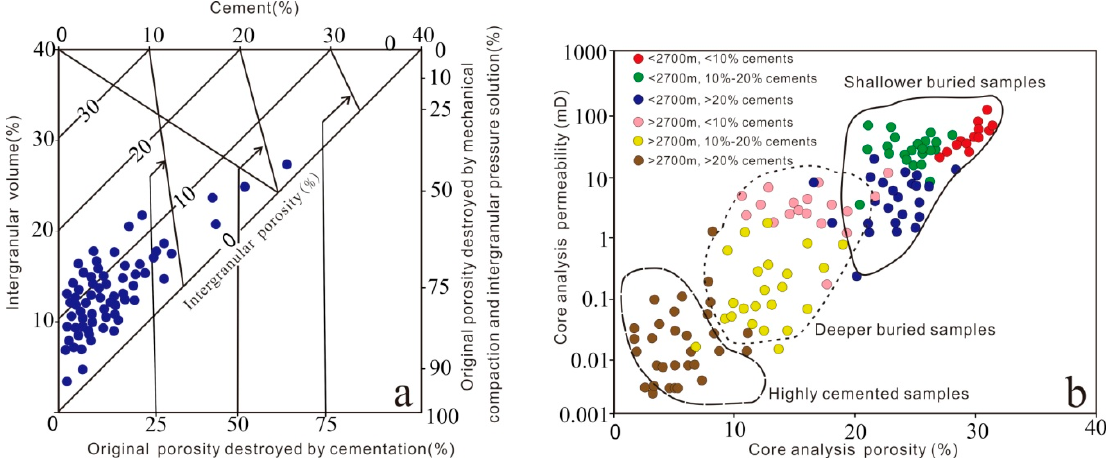
Figure 15. ( a ) Plot of intergranular volume (IGV) versus volume of cement, diagram after Houseknecht [68] and Ehrenberg [69]. ( b ) Core porosity versus core permeability of the Lulehe sandstones with different depth and cements content.